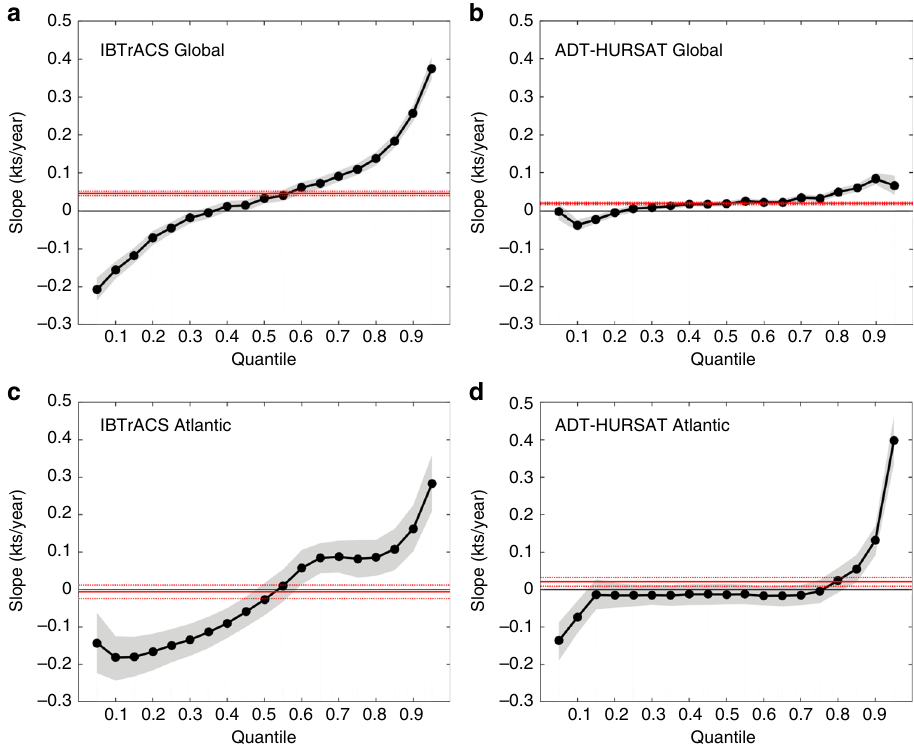
Fig. 2 Quantile regression of 24-h intensity changes. a – d Slope of the quantiles for 24-h intensity changes during the period 1982 – 2009. Slopes are shown for IBTrACS ( a , c ) and ADT-HURSAT ( b , d ) globally ( a , b ) and in the Atlantic basin ( c , d ). The black dots represent the slope derived from least squares regression of intensity change as a function of year for each quantile from 0.05 to 0.95 in steps of 0.05. Shading represents the 5th and 95th percentiles of the regressions with randomly perturbed observational data (Methods). The red solid line shows the (constant value) trend in the mean as measured by ordinary least squares regression, and the red dotted lines show the 90% con fi dence